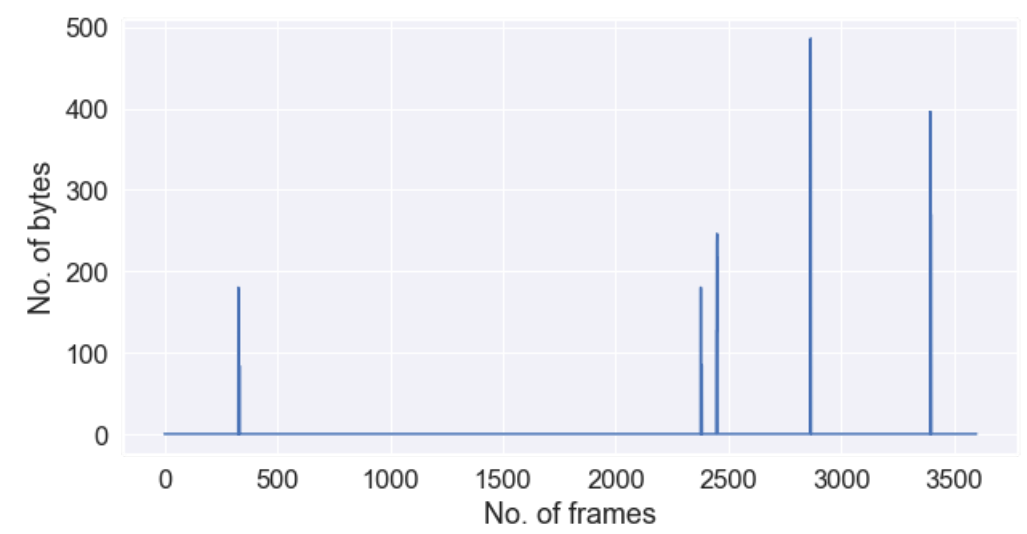
Figure 19b. Network bytes sent in